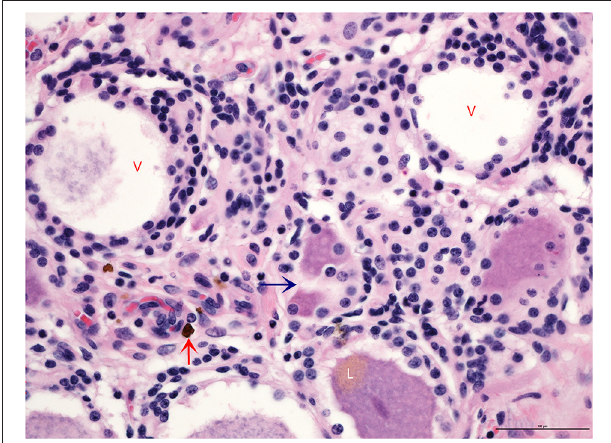
FIGURE 1 | Transverse section of a dorsal root ganglion showing neuronal cell bodies and their corresponding axons. Partial to complete absence of cytoplasm is evident in the larger vacuolated neurons (V), which are surrounded by increased numbers of satellite cells that appear to encroach upon the periphery of perikarya engulfing degenerate soma along with fewer microglia (blue arrow). The lower neuron shows polar accumulation of brown pigment granules, lipofuscin (L), an incidental finding. Vessels are cuffed by small numbers of hemosiderin-laden macrophages (red arrow). Overall cellularity of the ganglionic stroma is significantly increased ( N = 723) (H and E,